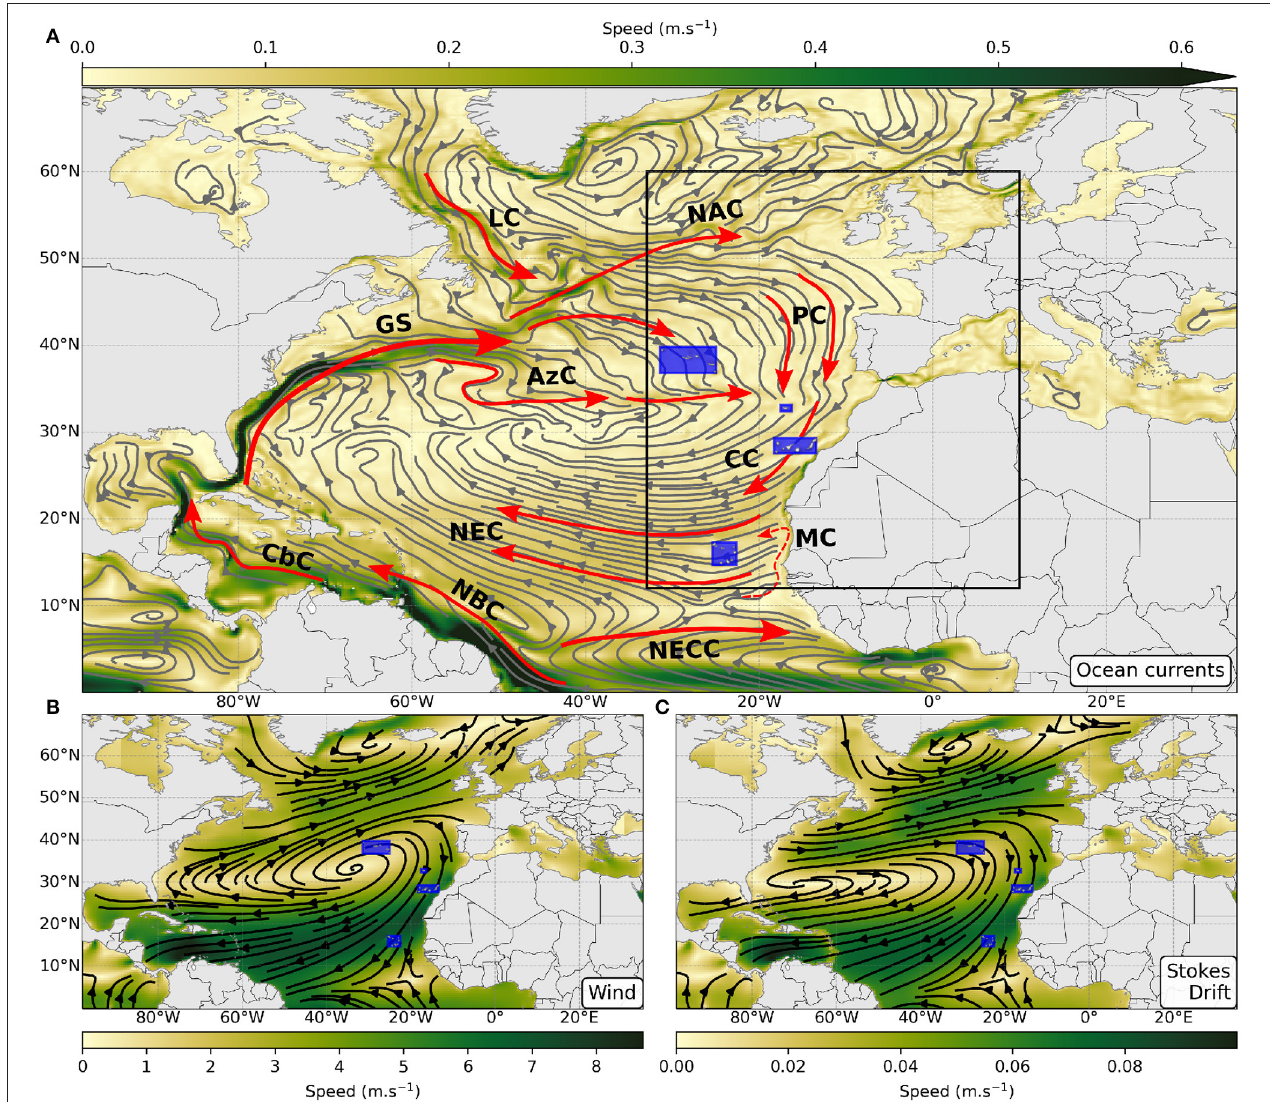
FIGURE 1 | Ten-year climatology (2006–2016) for: (A) ocean currents from CMEMS, (B) wind from ECMWF, and (C) stokes drift from WW3. Black area in (A) represents the delimitation of the finer-resolution ocean currents dataset (GLORYS12V1). Blue polygons mark the location of the Azores, Madeira, Canaries, and Cabo Verde archipelagos (from north to south). Red arrows represent the main ocean currents: Gulf Stream (GS), Labrador Current (LC), Azores Current (AzC), North Atlantic Current (NAC), Portugal Current (PC), Canary Current (CC), Mauritania Current (MC), North Equatorial Current (NEC), North Equatorial Counter Current (NECC), the North Brazil Current (BC), and the Caribbean Current